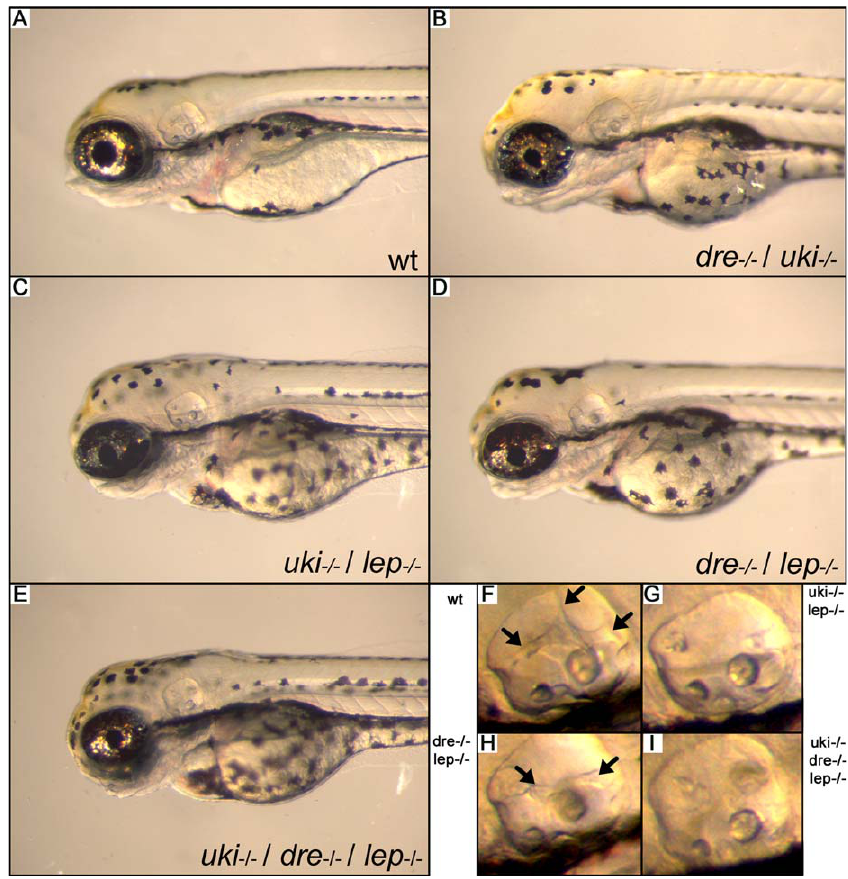
Figure 7. Phenotypic Analysis of dre/uki/lep Triple Mutants (A) Wild-type (wt) embryo at 96 hpf. (B–E) The indicated double and triple mutants do not show severe enhancement of the phenotype. (F–I) dre/lep double mutants have an ear phenotype comparable with a single mutant. In the uki/lep and dre/uki/lep triple mutants, the epithelial projections (arrows) fail to grow out to fuse in the middle of the ear to form the ear lumen. DOI: 10.1371/journal.pgen.0010019.g007